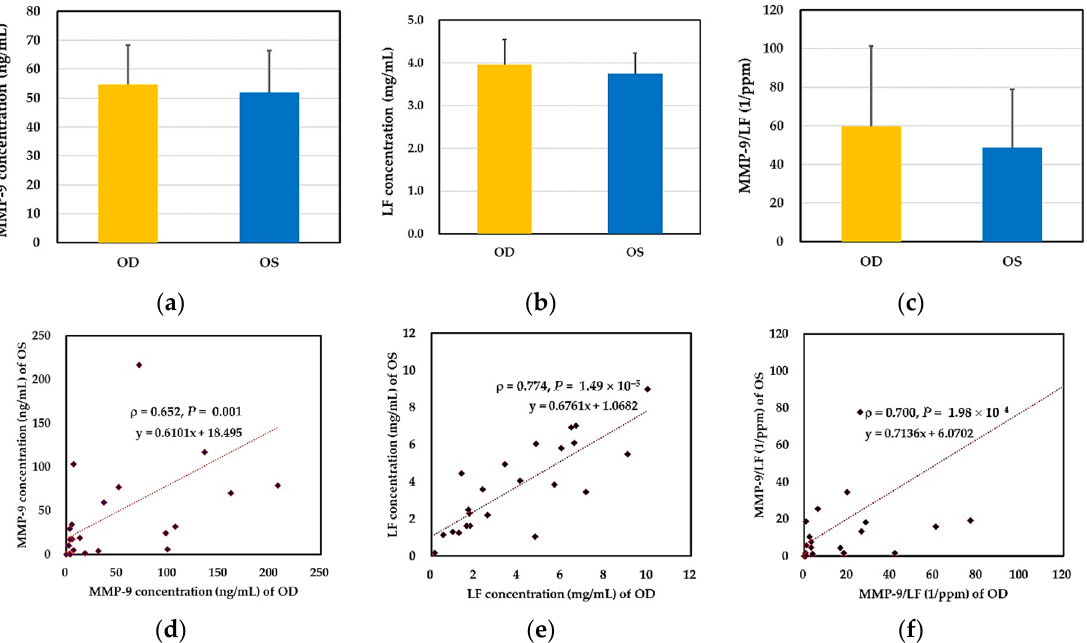
Figure 1. Comparison of the expression of 2 representative biochemical markers in both eyes of dry eye patients ( N = 23). ( a ) concentration of tear matrix metallopeptidase 9 (MMP-9) ( p = 0.9881); ( b ) concentration of tear lactoferrin ( p > 0.9999); and ( c ) concentration ratio of MMP-9 to lactoferrin of each tear sample ( p = 0.7540). ( d ) correlation of tear MMP-9 concentration; ( e ) correlation of tear lactoferrin concentration; ( f ) correlation of concentration ratio of MMP-9 to lactoferrin of binocular tear samples of each patients. Abbreviation: LF, lactoferrin.